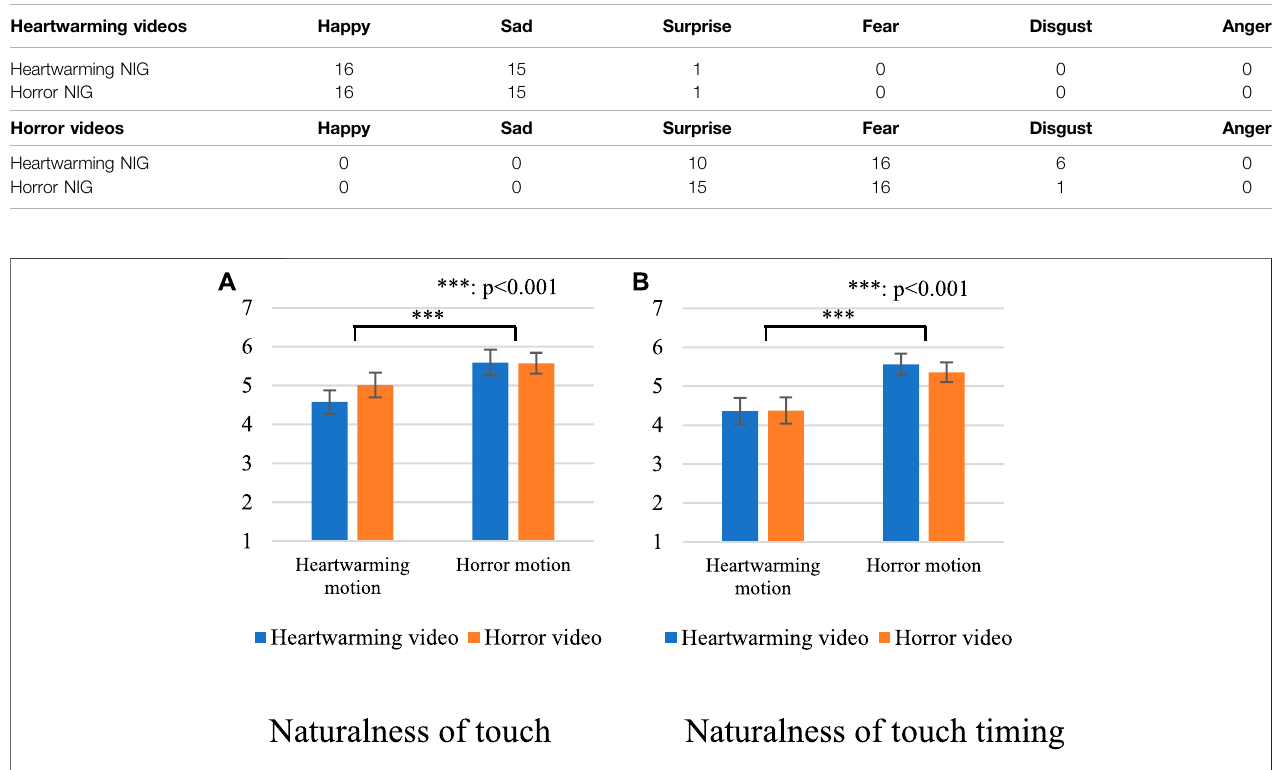
FIGURE 4 | Questionnaire results with all videos. (A) Naturalness of touch. (B) Naturalness of touch timing.